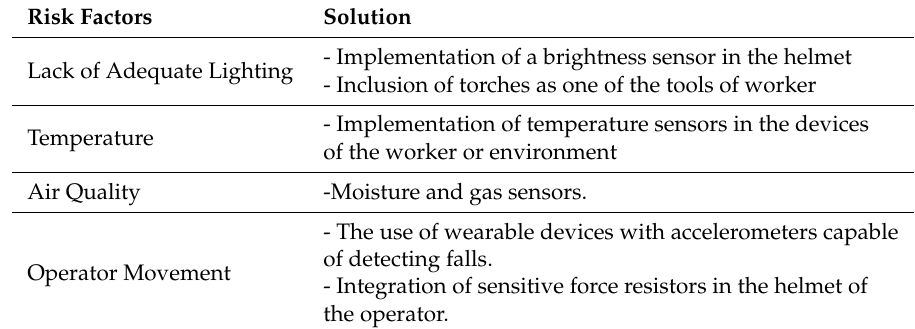
Table 6. Identification of electronic components for the prevention of risks in the worker’s